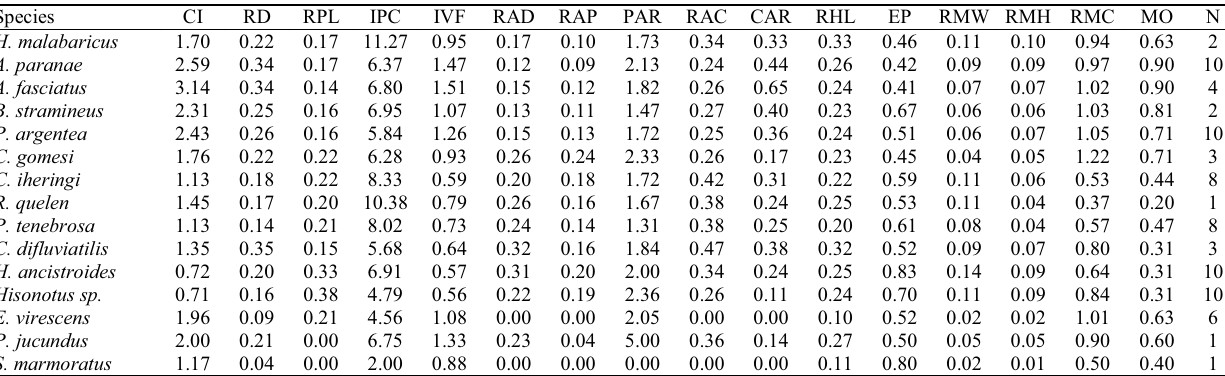
(Figs. 11-12). Three ecomorphological attributes contributed